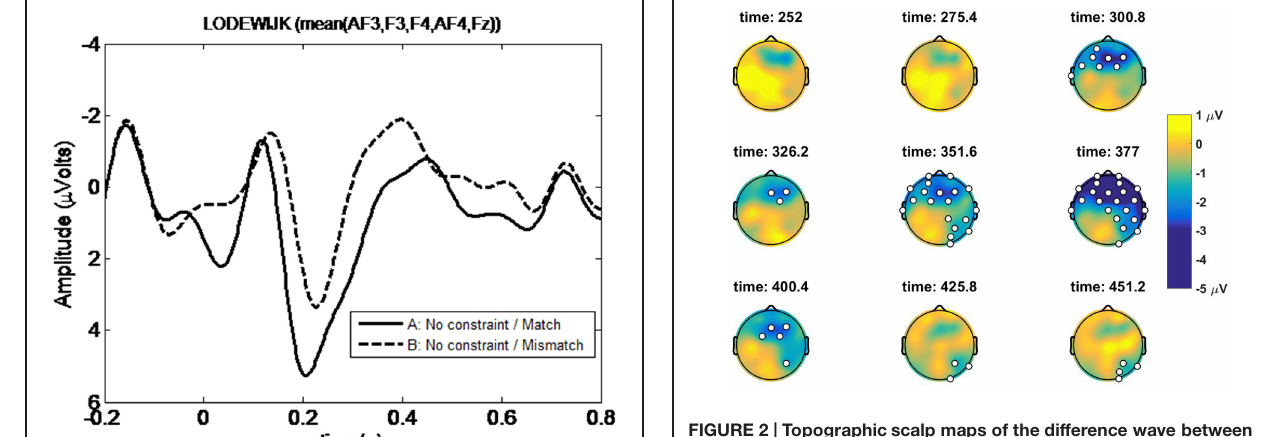
FIGURE 2 | Topographic scalp maps of the difference wave between the No-Constraint Mismatch and the No-Constraint Match condition at a series of discrete time positions. The electrodes that were significantly different between the two conditions in the cluster mass univariate analysis ( p < 0.07) are marked in white.